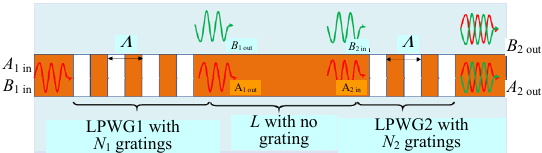
Fig. 1 Schematic diagram of the cascaded LPWG structure.